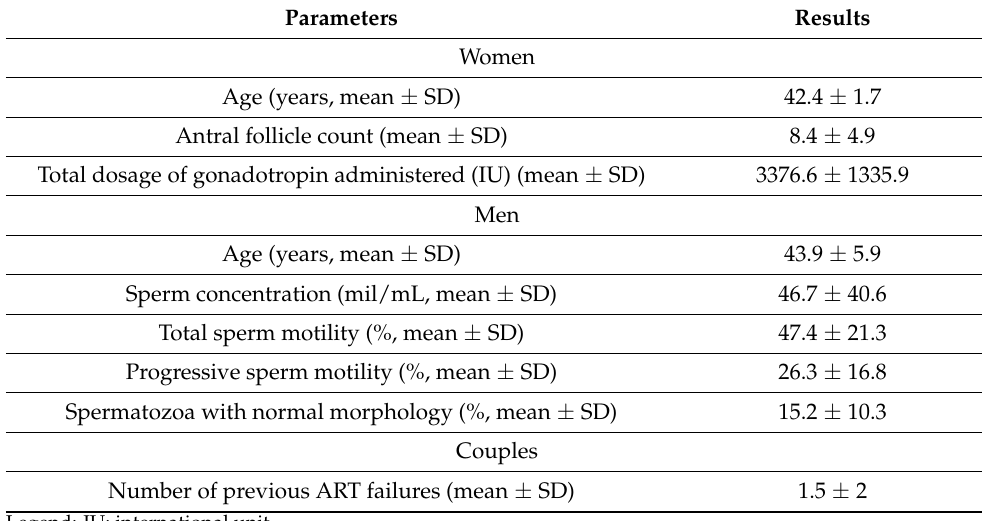
Table 1. Demographic and clinical characteristics of the female and male partners of the couples enrolled in this study.